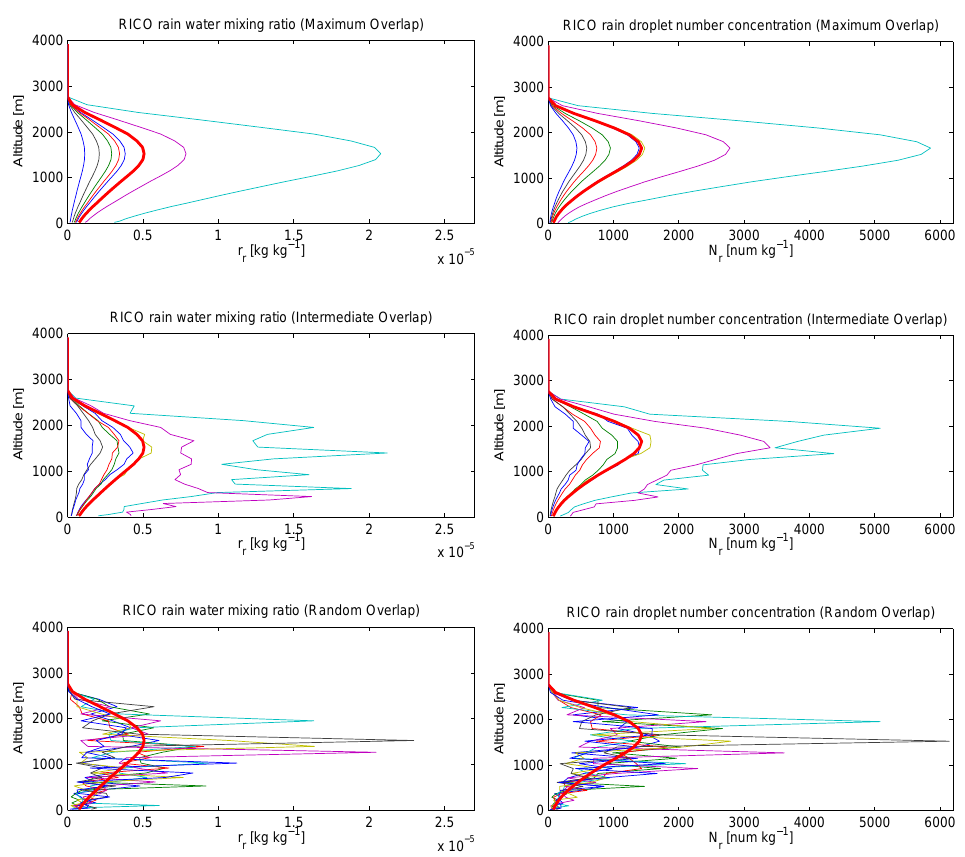
Fig. 6. A sample of eight equally weighted SILHS-generated profiles (thin lines) and the analytic grid-box mean profile (thick red line) drawn from a single time step during the RICO shallow cumulus simulation. (Importance sampling is foregone for the purpose of illustration in Figs. 6 through 9.) The vertical correlation within each profile is specified to be maximal (upper panels), intermediate (middle panels), or random (lower panels). Plotted are the rain mixing ratio (left figure column) and rain number mixing ratio (right figure column) fields from the same eight profiles. The color coding of the sample profiles is the same in both figure columns. By comparing lines of the same color in both the right-hand and left-hand halves of the figure, one may see that the profiles of rain mixing ratio and number mixing ratio are highly correlated to each other. This result is expected because high correlation is specified in these simulations. The degree of vertical overlap in SILHS can be adjusted as desired between maximal and